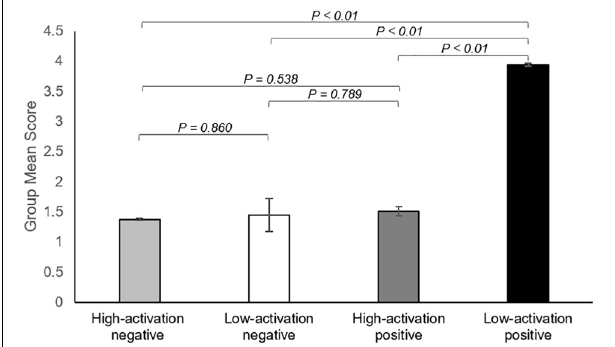
FIGURE 4 | Summary of the results showing changes in affect state after viewing ASMR, relative to before watching ASMR. Bar graphs represent group mean scores for affective state assessed using the Multi-Affect Indicator (Warr, 1990). All variables range from 1 to 7. For self-reported changes in affect, 1 = much less; 7 = much more. The participants had the most increase in low-activation positive state during the ASMR condition among four affective states: low-activation positive state (group mean ± standard deviation: 3.94 ± 1.46), high-activation positive state (1.51 ± 0.63), low-activation negative state (1.45 ± 0.64), and high-activation negative state (1.38 ± 0.78). Statistical significance was determined by a p -value of less than